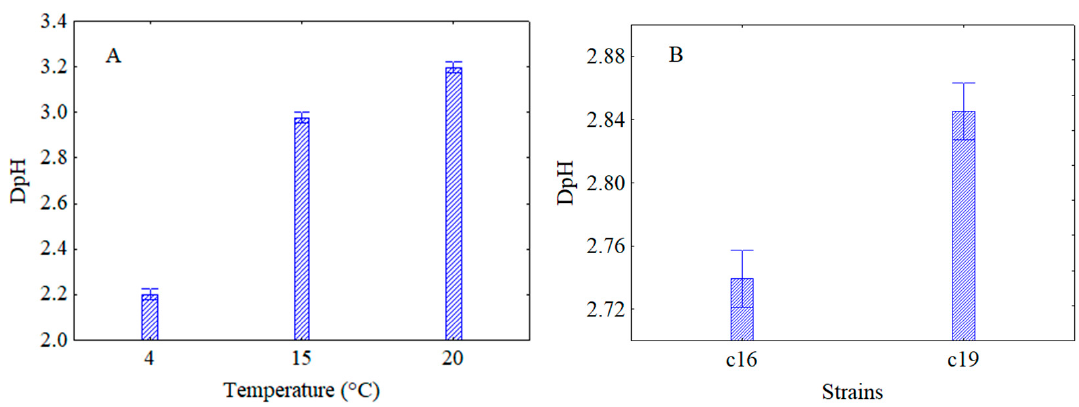
Figure 6. Decomposition of the statistical hypothesis for the effects of temperature of storage ( A ) and strains ( B ) on acidification. Bars denote 95% confidence intervals. Experiment on the effect of a thermal abuse in rice beverage for L. plantarum c16 and c19.